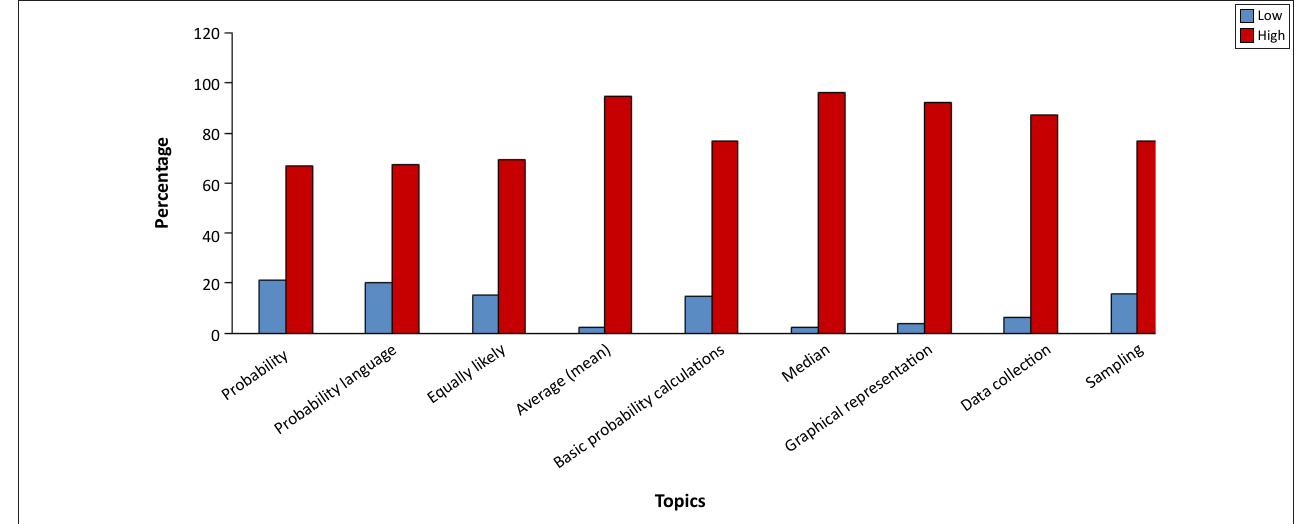
FIGURE 1: Teacher confidence levels.